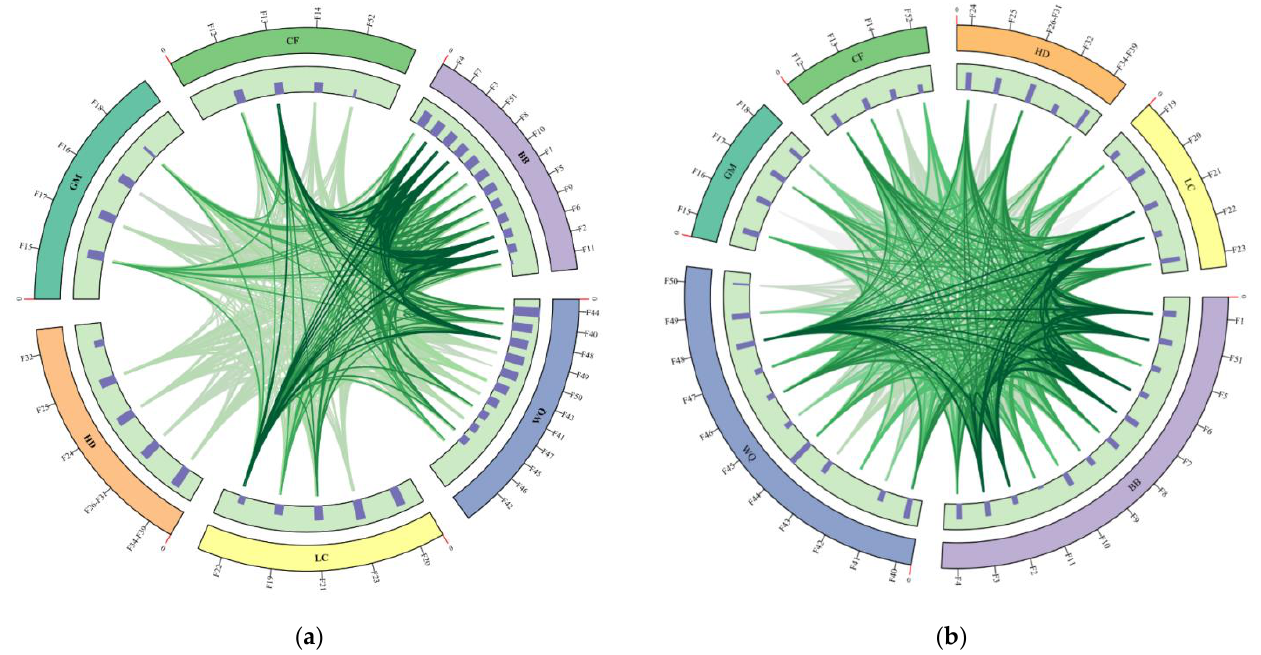
Figure 5. Application of the River Function Linkage Assessment Tool (RFLAT) ( a ) results of individual